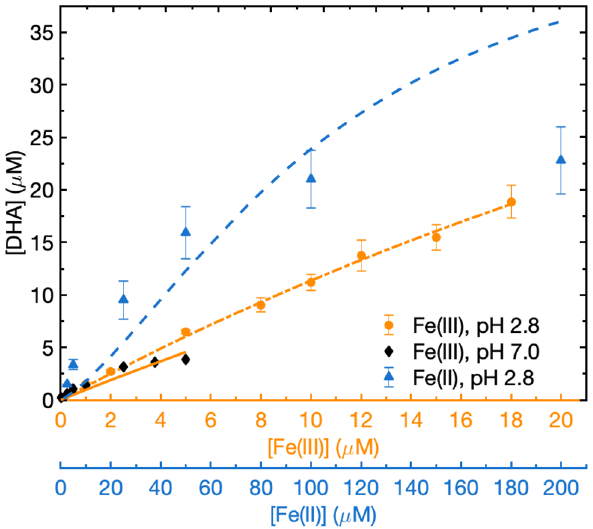
Figure 2. DHA formation from ascorbic acid oxidation in the presence of Fe(III) or Fe(II) ions. The circles, diamonds and triangles represent experimental data for Fe(III) at pH 2.8 and 7.0 (orange abscissa), Fe(II) at pH 2.8 (blue abscissa), respectively. Error bars are shown for data with three measurements; measurements at pH 7 are only one repeat. The orange dashed line, orange solid line and blue dashed line denote corresponding modeling results based on reactions in Tables 1 and 2. Because of the additional uncertainties and lack of relevance of the high Fe(II) concentrations, only experimental data for Fe(II) concentration within 200 µM at pH 2.8 is shown in the figure.